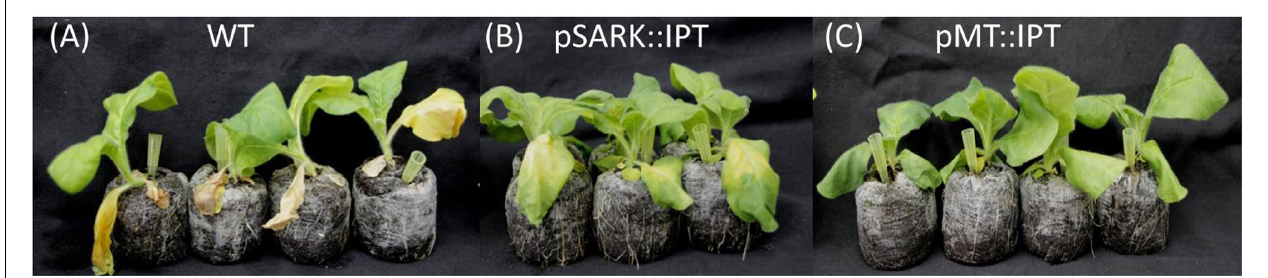
FIGURE 4 | Responses of transgenic compared to WT tobacco plants after salinity stress. Three-week old tobacco plants watered with NaCl solution (100 and then 200 mM) for 3 weeks. (A) WT plants, (B) pSARK:IPT plants, (C) pMT:IPT plants. The photo represents one of three independent experiments showing similar results.